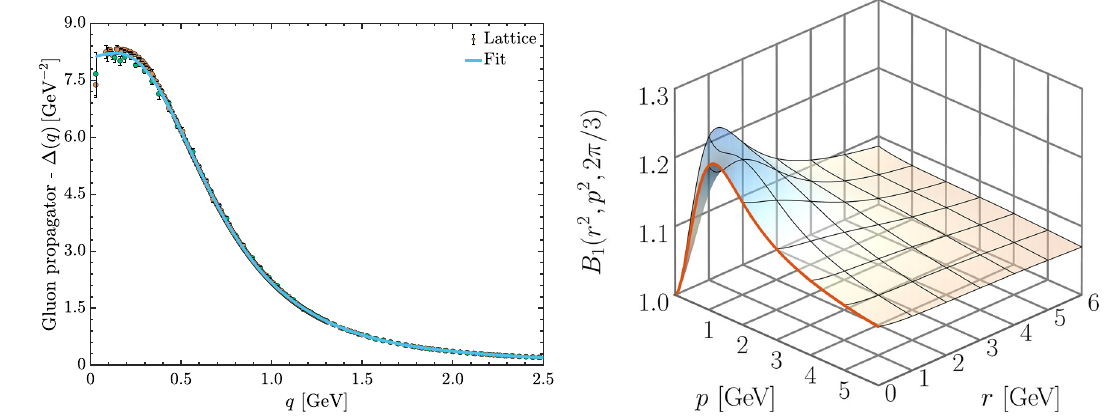
Fig. 8 Left panel: The lattice data of [55,59,60,72] (circles), and the corresponding fit (blue continuous curve) for the gluon propagator, (cid:4)( q ) . Right panel: The ghost-gluon form factor B